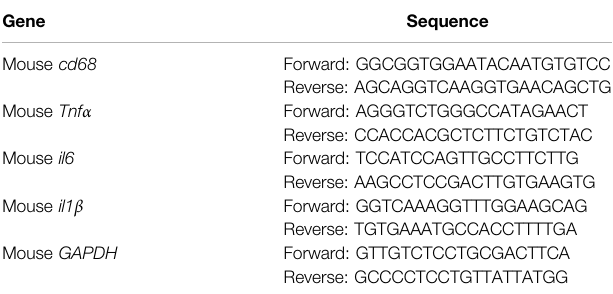
TABLE 1 | Primers for qPCR.